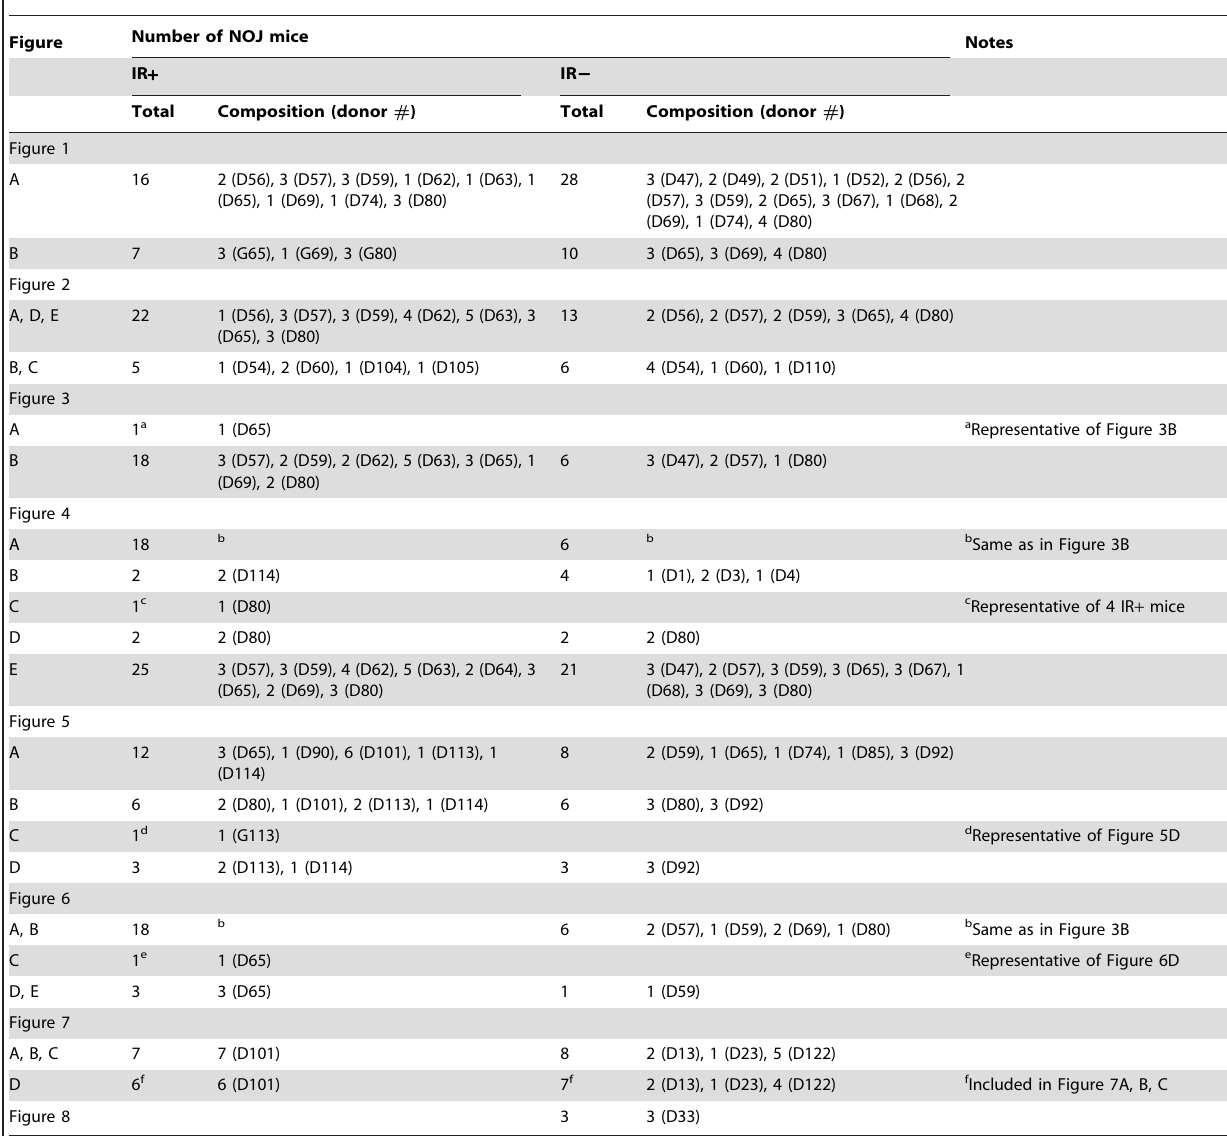
Table 1. The number of mice used in the present study.